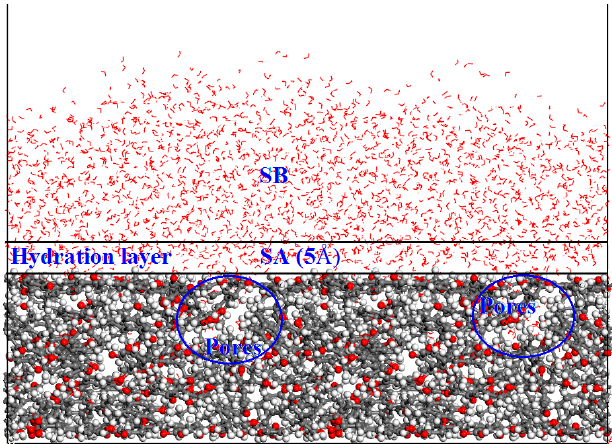
Figure 4. Final configuration of the coal-water (CW) system.